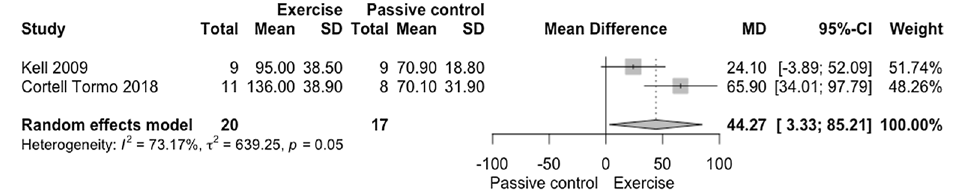
Figure 3. Forest plot of the comparison of exercise vs. passive control on trunk extensor endurance. Cortell- Tormo et al. (2018) 72 : Exercise versus No intervention—(s). Kell et al. (2009) 51 : Resistance exercises versus No intervention—Sorensen test (s).